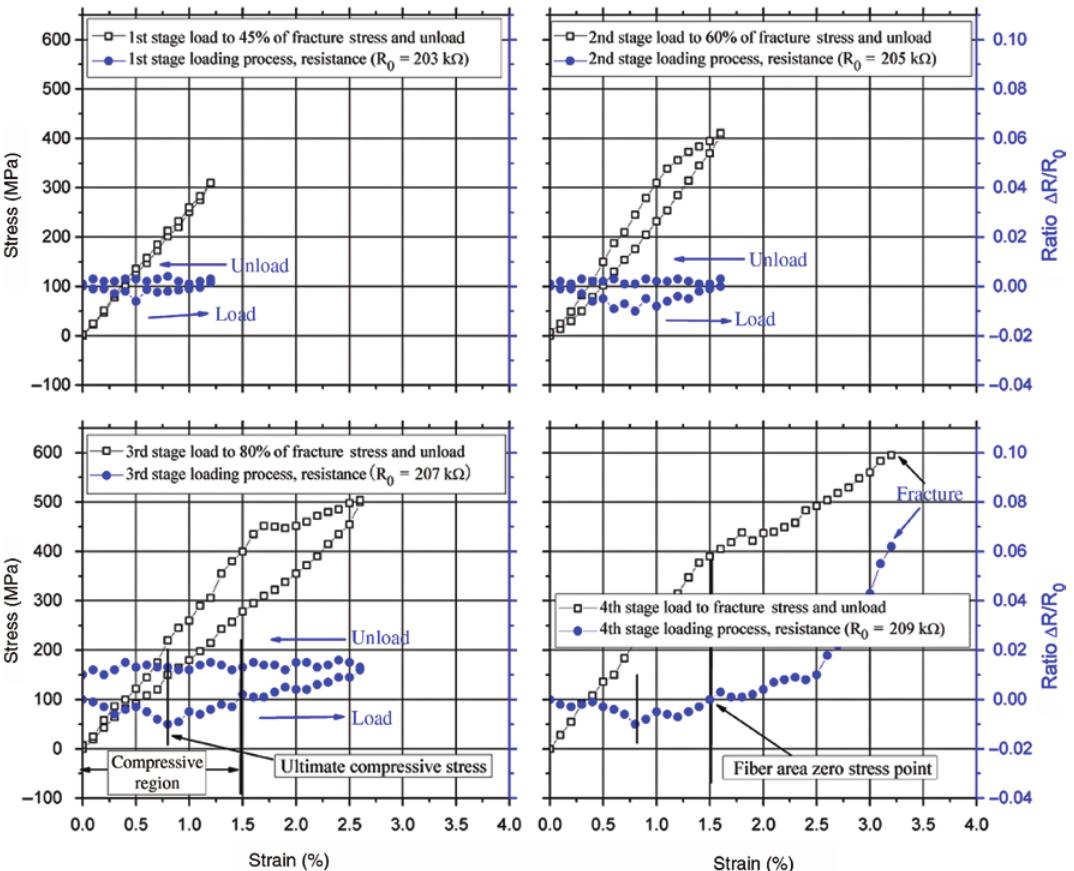
Figure 12: The strain and resistance change rate of specimen D of three-point bending for four different incremental load-unload tests in compressive